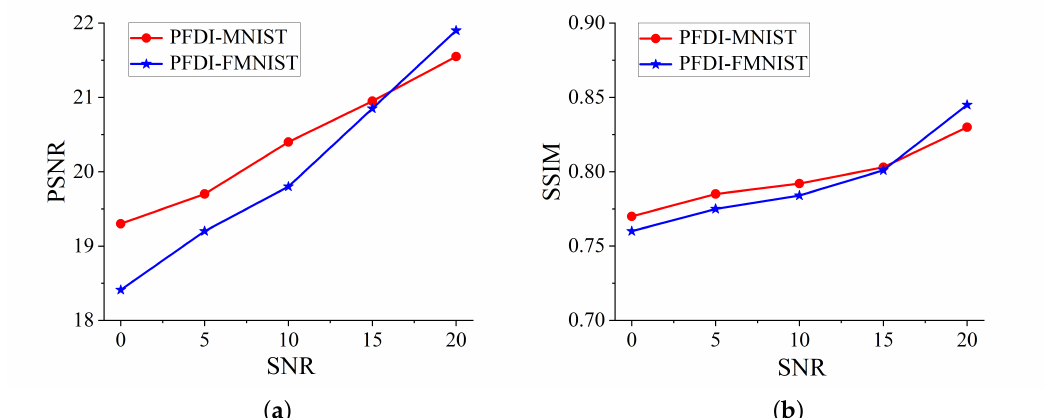
Figure 10. Imaging results with different SNR. ( a ) PSNR performance. ( b ) SSIM